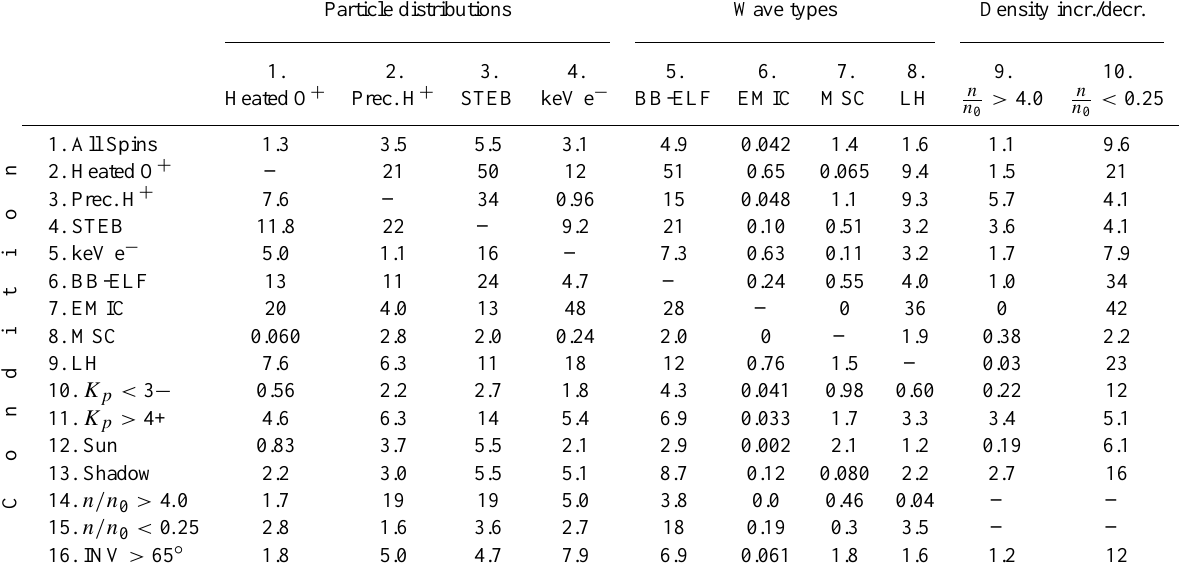
Table 1. Conditional probability (in %) of observing various particle distributions, waves types, and electron density enhancements or reductions (listed in the title row) in the presence of the particle distributions, waves types, and other characteristics in the leftmost column (see the text for more details). Row 1 indicates the probabilities of detecting the wave and particle properties in the entire database of